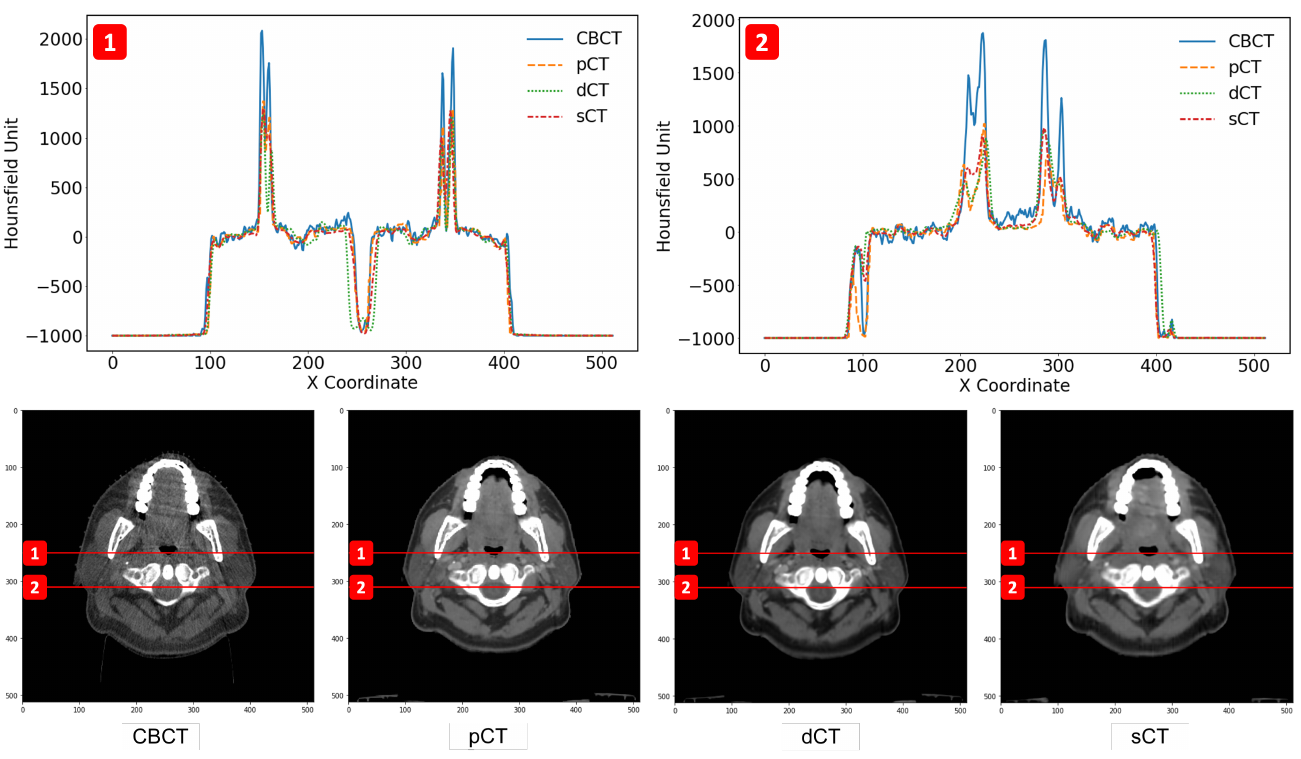
Figure 8. HU line profiles of CBCT, pCT, dCT, and sCT on two different lines passing through the patient’s body in different areas. The top two images show each HU line profile (1 and 2) corresponding to the two red dashed lines (1 and 2) shown in each of the bottom four images of CBCT, pCT, dCT, and sCT.